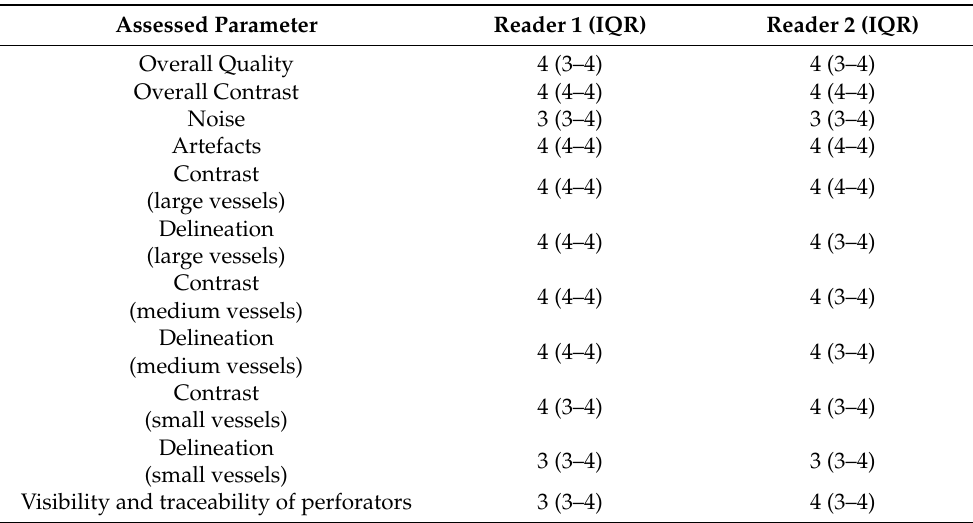
Table 1. Medians and interquartile range (IQR) of qualitative parameters of 50 UHR-CTA images rated by two trained readers (radiologists).